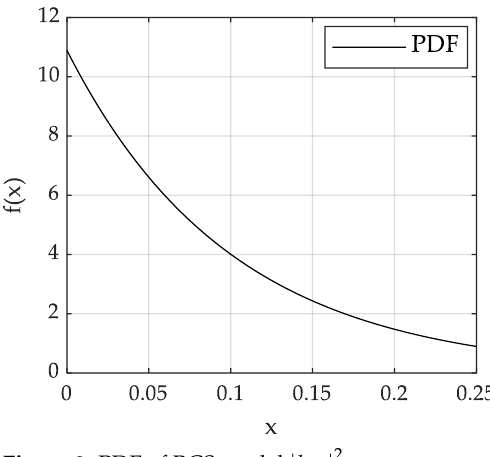
Figure 1. CDF of RCS model | h 11 | 2 .